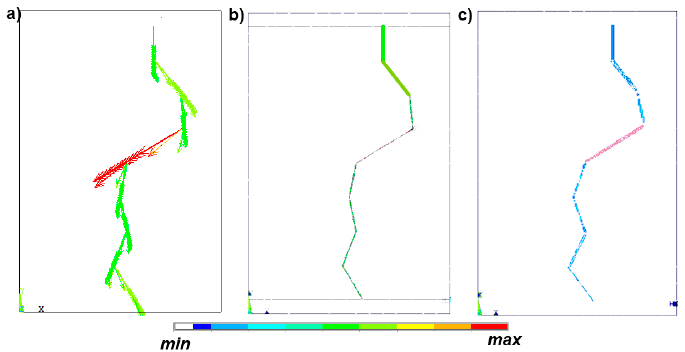
Figure 16. Current density vectors ( a ), current density distribution ( b ), and heat sources distribution ( c ) in the breakdown (arc) stage of discharge analysis.